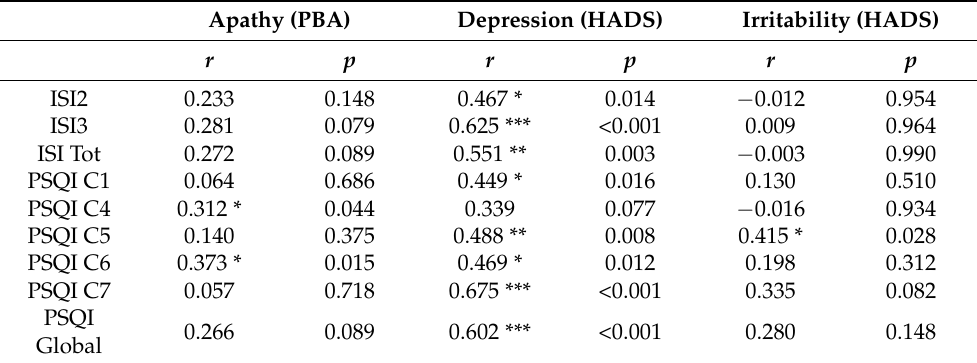
Table 4. Pearson’s correlations (and related level of significance) between mood and behavioural aspects and sleep subscale. Apathy (PBA) Depression (HADS) Irritability (HADS)